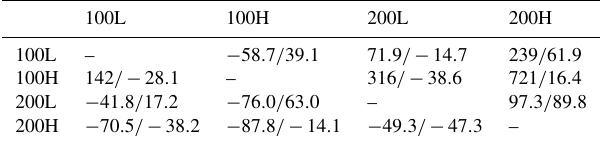
Table 7. Changes in mean transport efficiency for the column name experiment, given relative to the row name experiment, for GSD broad and GSD narrow respectively. Values are given in percent (%).